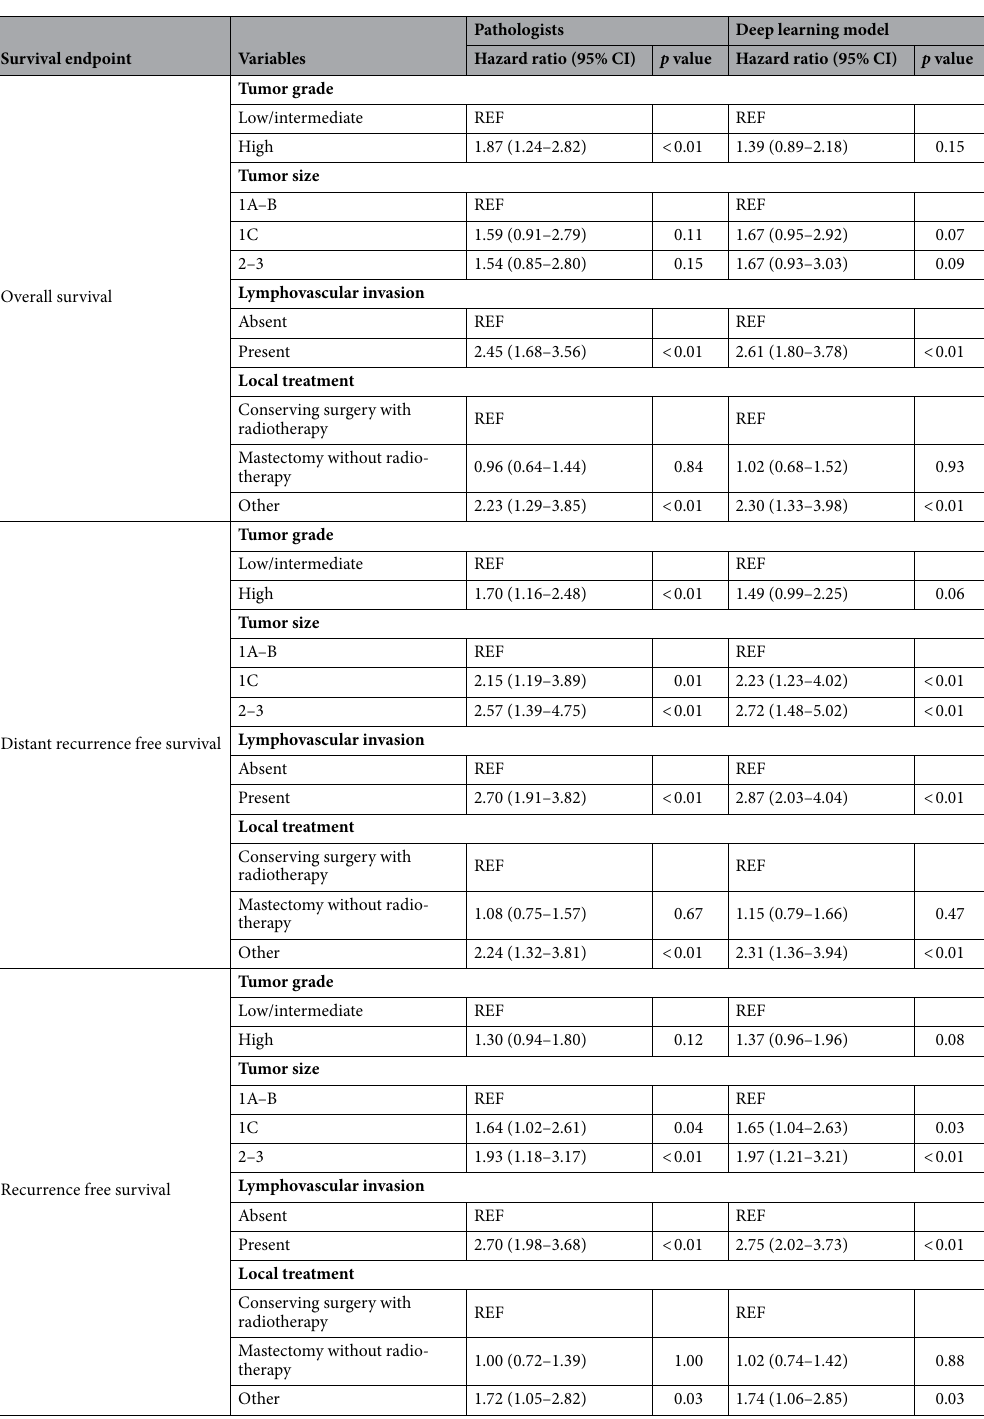
Table 6. Multivariate hazard ratios showing the prognostic value of high versus low/intermediate grade tumors as assessed by pathologists or the deep learning model for different survival endpoints. This model was stratified by molecular subtype. Results are shown on the test set ( n =